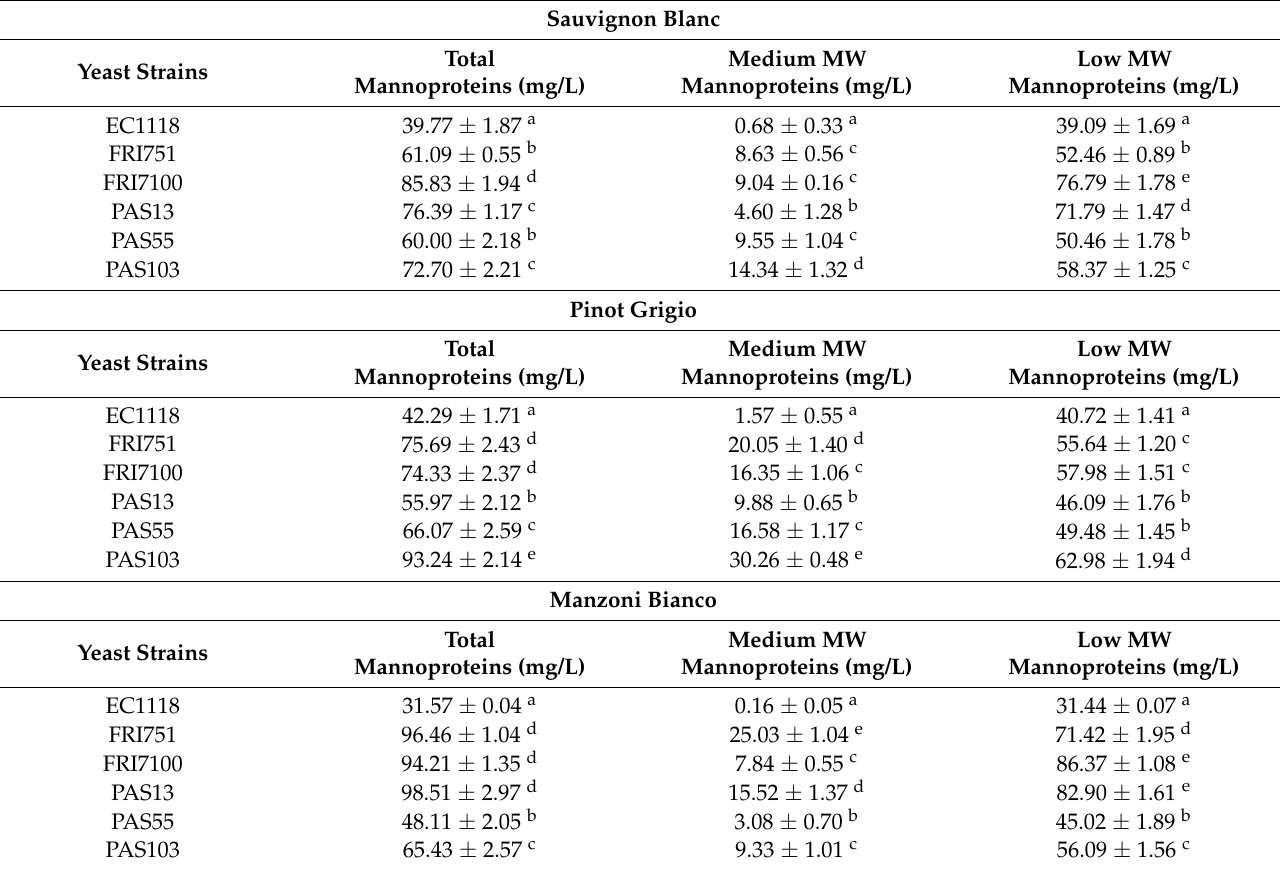
Table 7. Mannoproteins released by yeasts during fermentation in Sauvignon blanc, Pinot grigio, and Manzoni bianco wine. Sauvignon